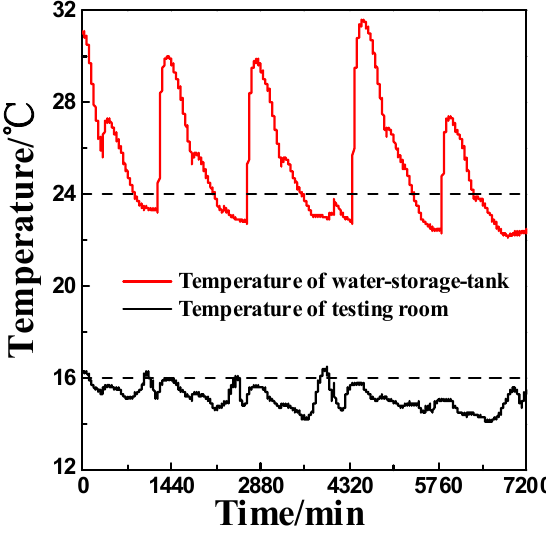
Figure 5. Diagram of temperature of the testing room and water-storage-tank over